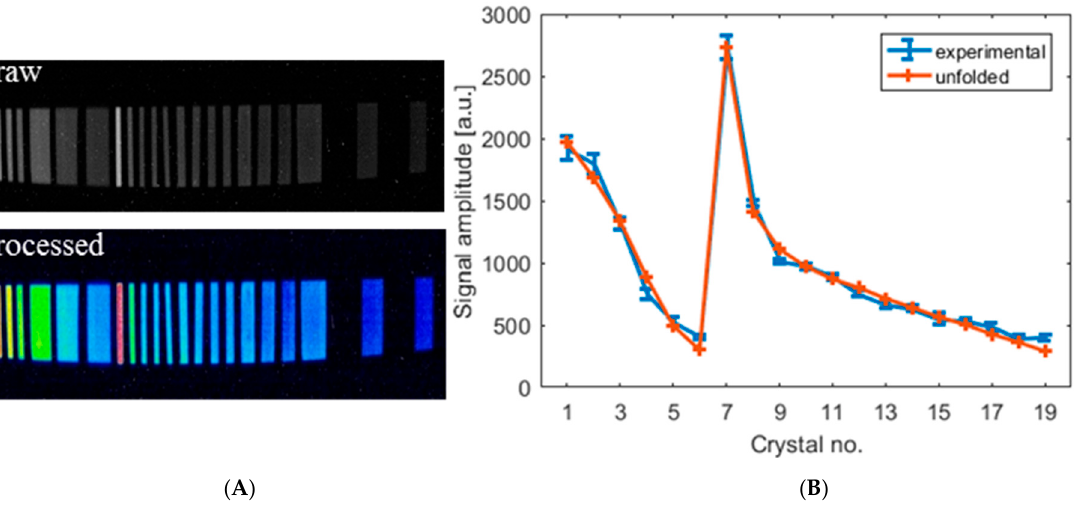
Figure 18. ( A ) Raw image of the scintillator emission and corresponding processed image. ( B ) Analyzed data showing the signal amplitude emitted by each crystal.